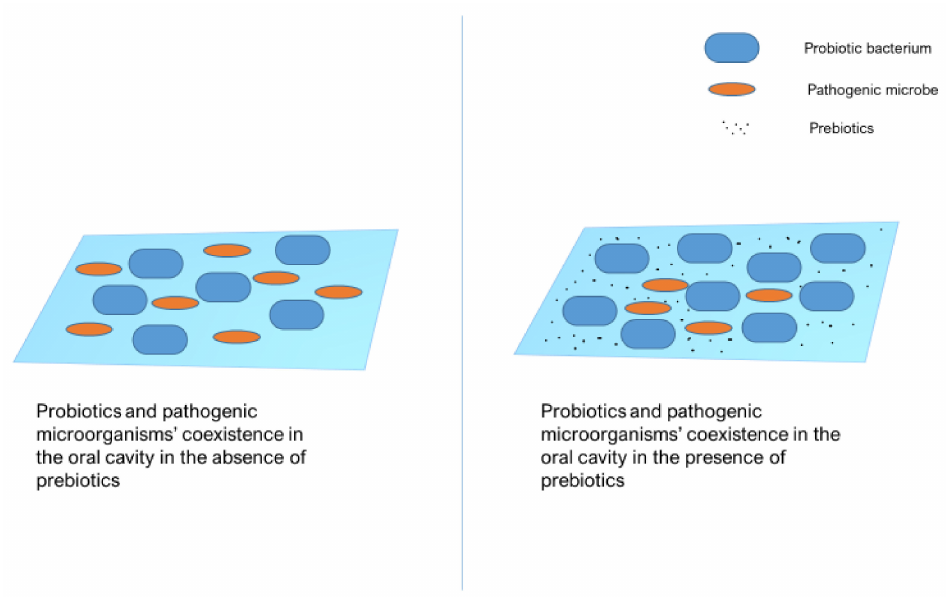
Figure 1. Synbiotics are products containing both probiotics and